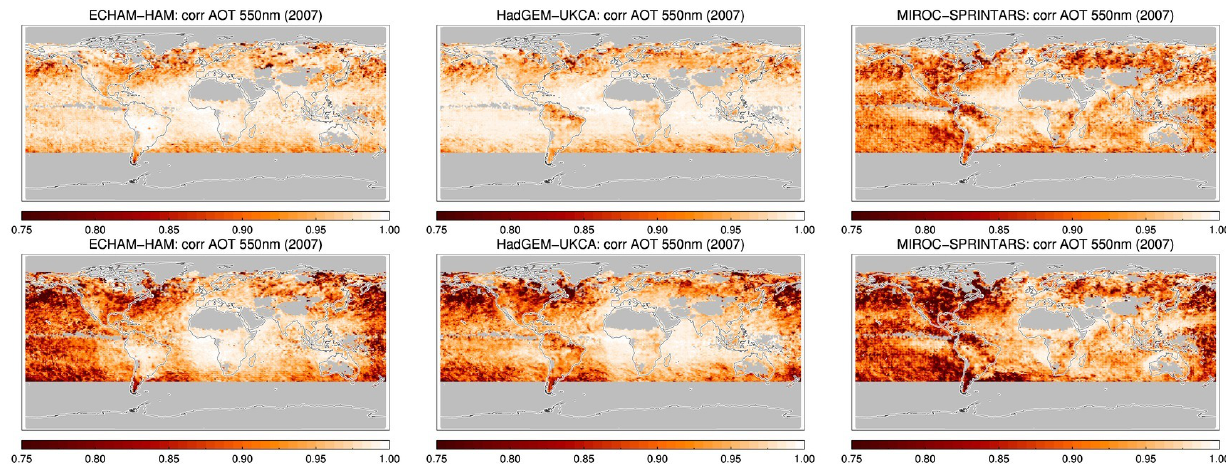
Figure 13. Correlation between model AOT at the time of MODIS-NRL Aqua observation and a 24h model AOT average. Top: 24h model average uses overpass time as the centre for the 24h average; bottom: 24h average defined according to UTC. Note how in the bottom plot, correlations drop off towards the